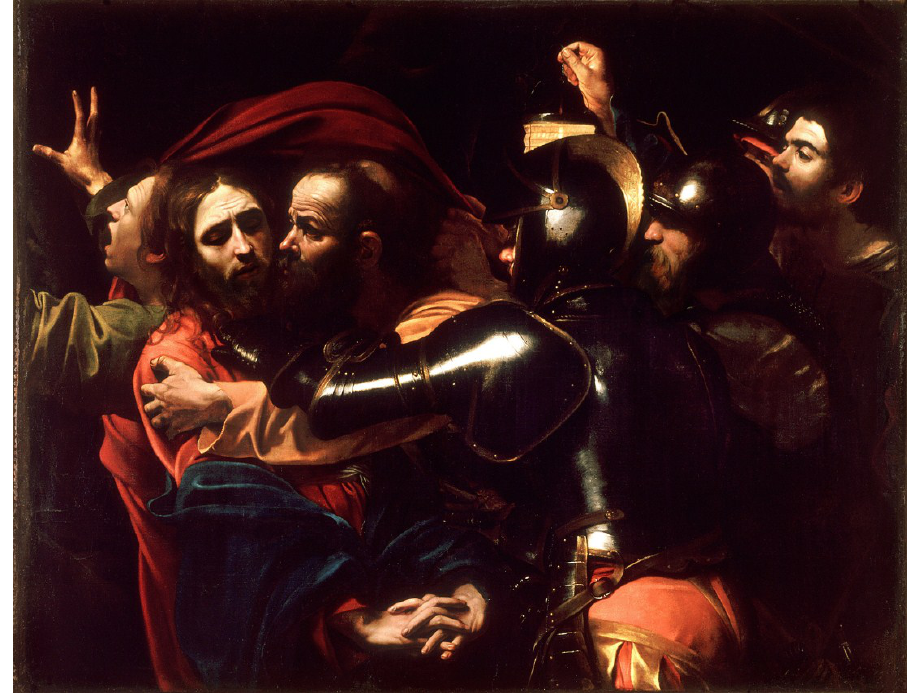
Figure 14. Betrayal of Christ (c. 1602). By Caravaggio. National Gallery of Art, Dublin. Photograph from Wikimedia and flagged for noncommercial use.